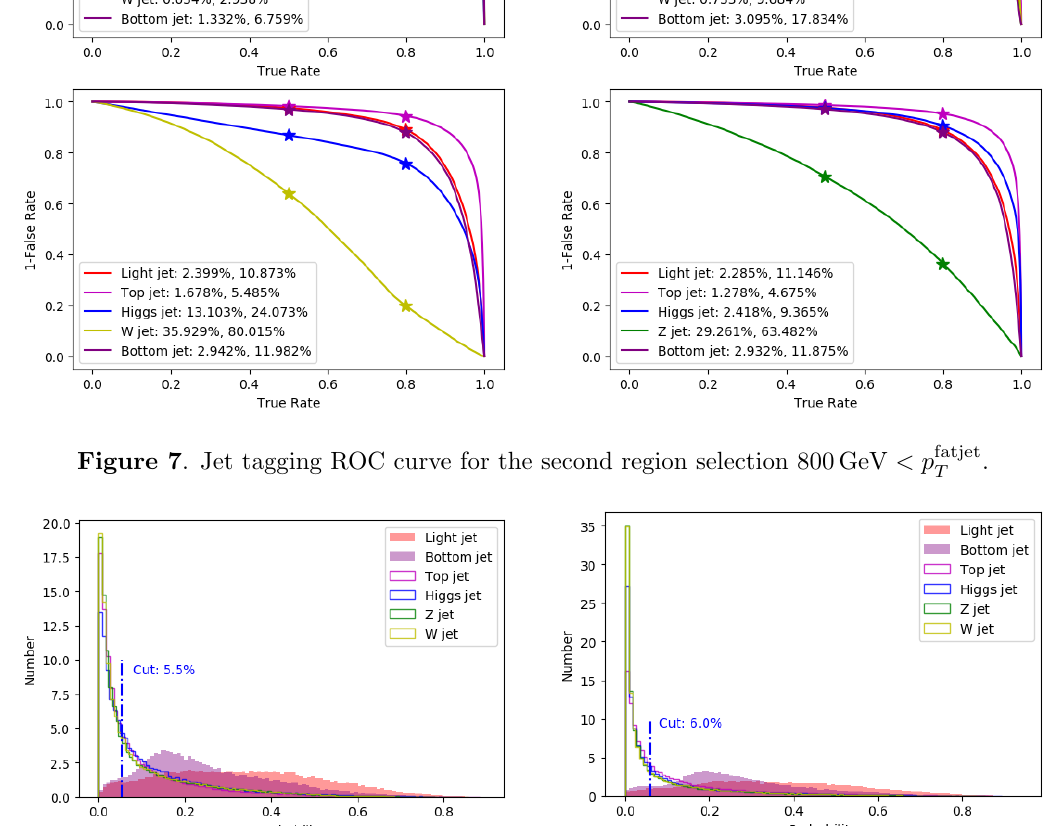
Figure 8 . Probability distribution to identify a jet as light, for 400 GeV < p jet and 800 GeV < p jet (right). The blue dashed line is the cut selected to reject 95% of the QCD jets T (light jets plus bottom